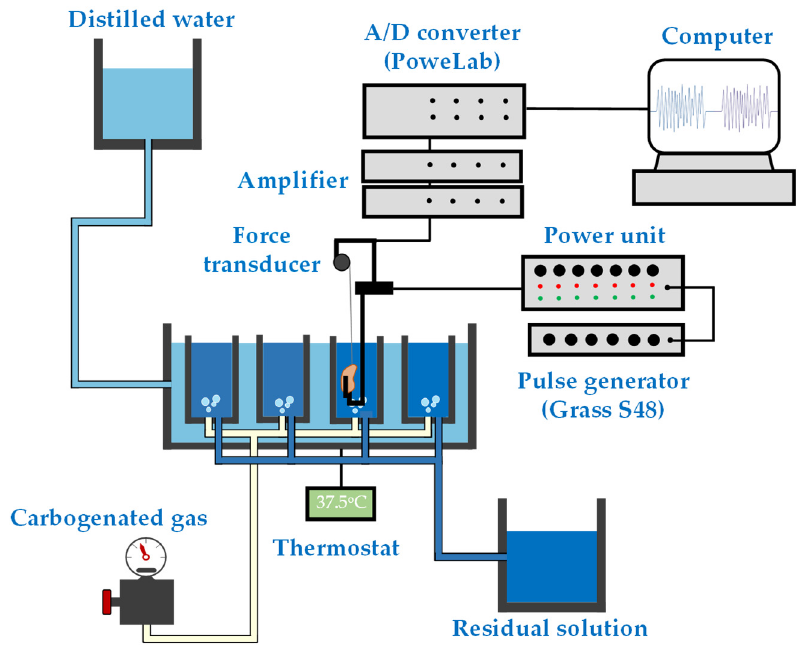
Figure 1. Experimental setup for the recording of mechanical contractions of cardiac